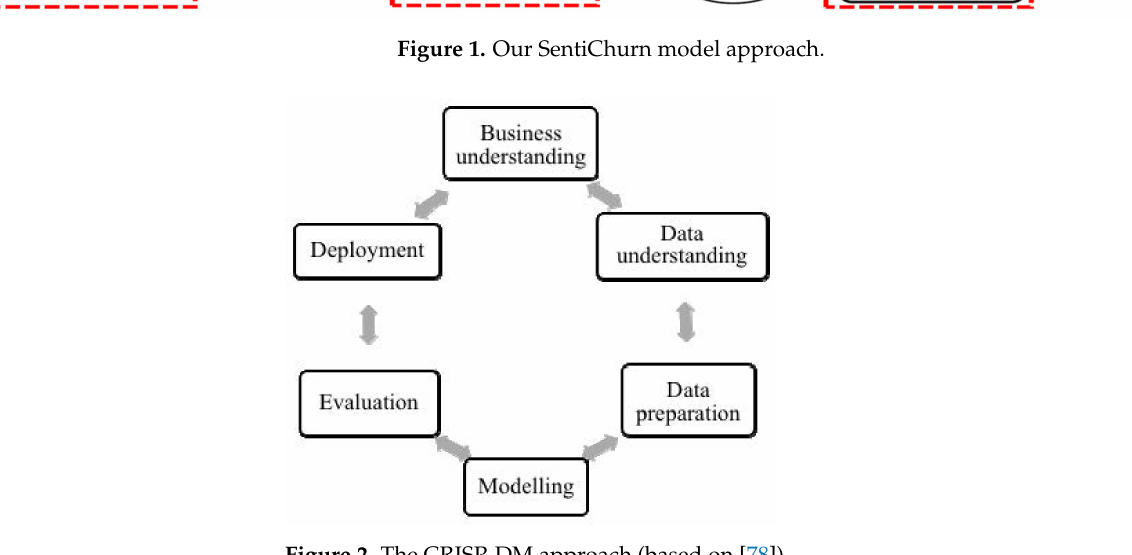
Figure 2. The CRISP-DM approach (based on